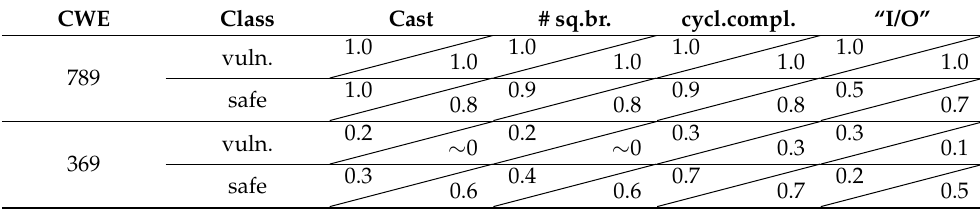
Table 2. Sensitivity of the models to different strength of concepts: each cell corresponds to one concept/CWE/class experiment, and each shows classification accuracy on instances with strong presence of the concept (top triangle) and on inputs with little presence of it (bottom triangle). CWE Class Cast #